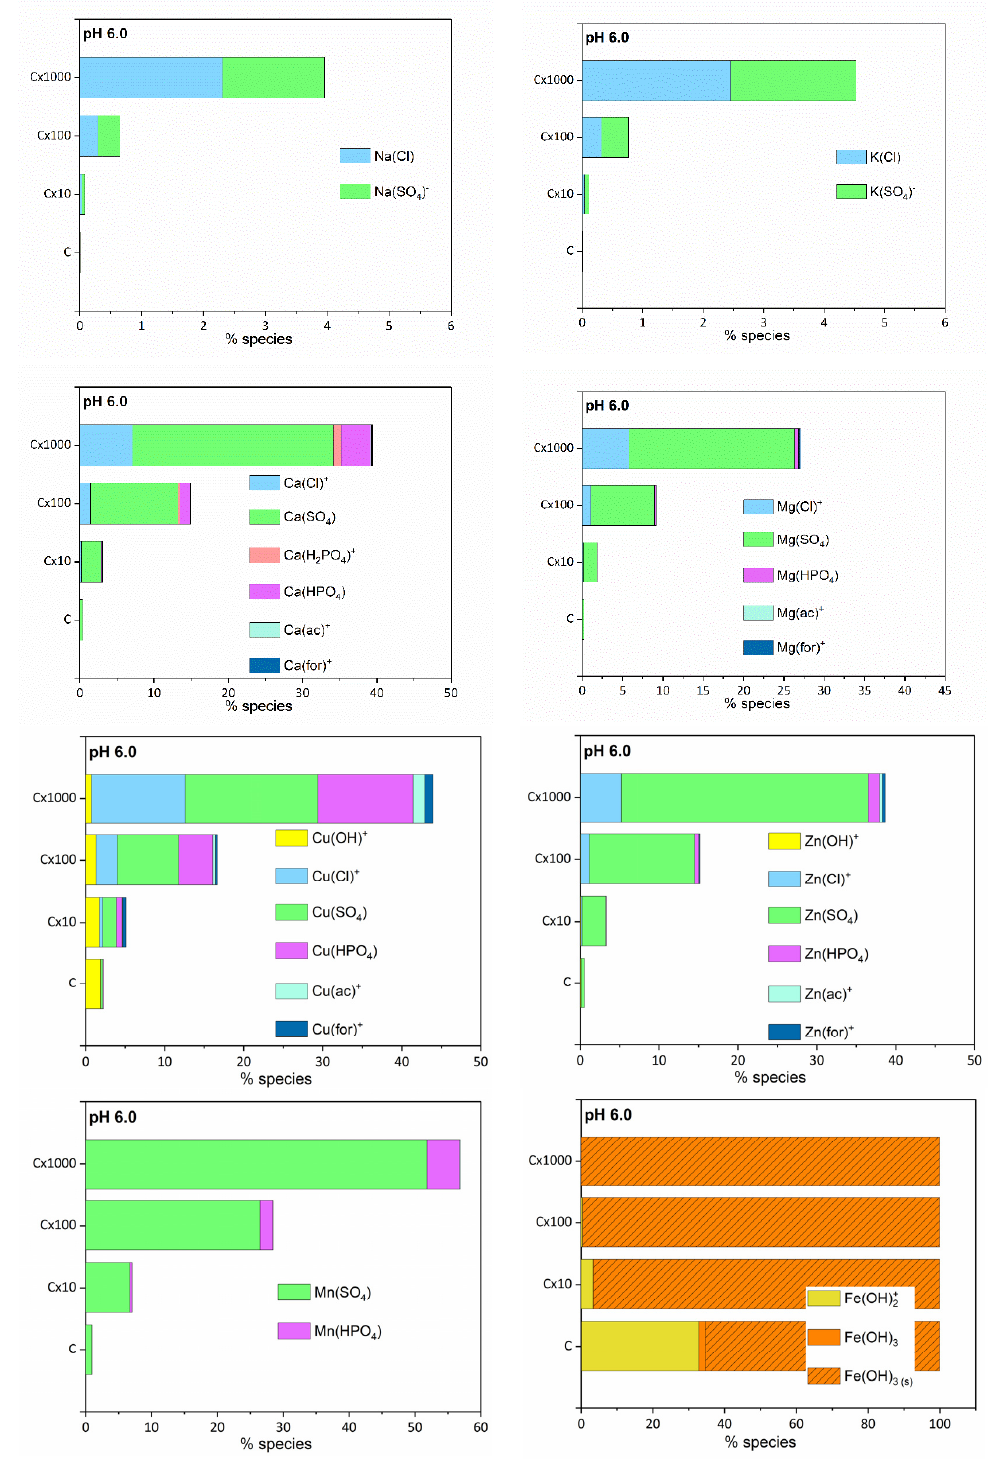
Figure 7. Percentages of cations involved in the different species, as a function of the concentration level of the components, at pH 6.0. The concentrations are those of the atmospheric deposition sample D1-1 (C) or the same multiplied by a factor 10, 100, or 1000.